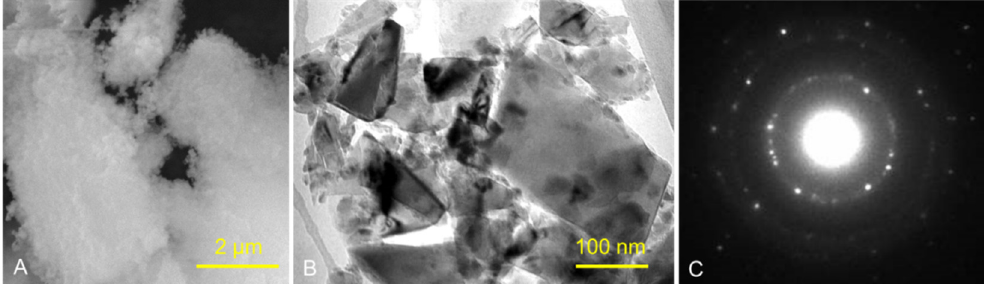
Figure 1. ( A ) SEM micrograph of ND powder, ( B ) TEM image of ND powder, and ( C ) corresponding selected-area electron diffraction (SAED) pattern of ND crystalline particles.